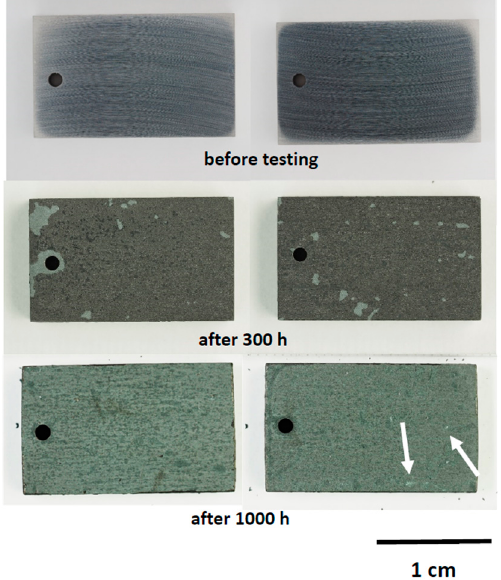
Figure 6. HT347HFG specimens before and after exposure to steam at 25 MPa at 700 °C.